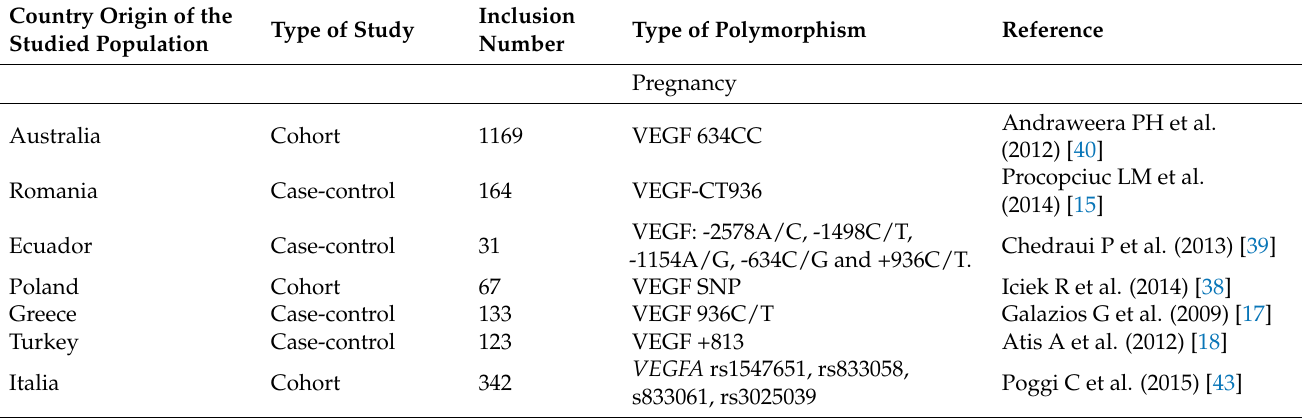
Table 1. Type of